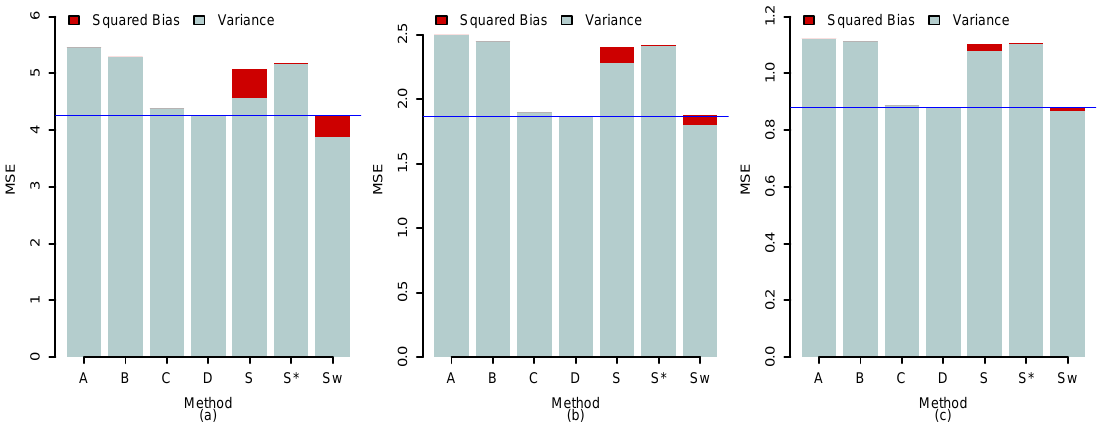
Figure 2. ( a ) n 1 = 3, n 2 = 5, n 3 = 7, ( b ) n 1 = 5, n 2 = 10, n 3 = 15, and ( c ) n 1 = 10, n 2 = 20, n 3 =